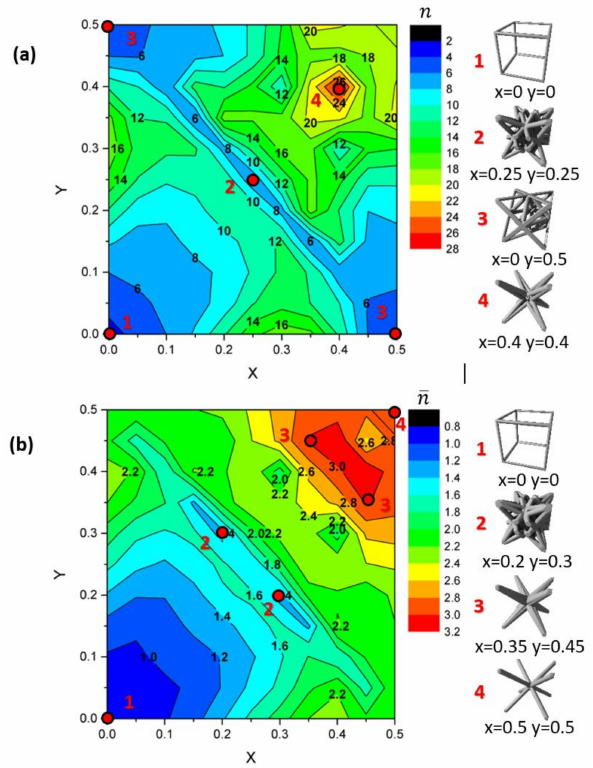
Figure 6. Parameter n indicating the dependence of the stress concentration factor on density for: ( a ) K = σ m / (cid:101) σ and ( b ) K = σ / (cid:101) σ . The optimal solutions to maximize the yield stress are highlighted in red and the solutions to minimize it are indicated in